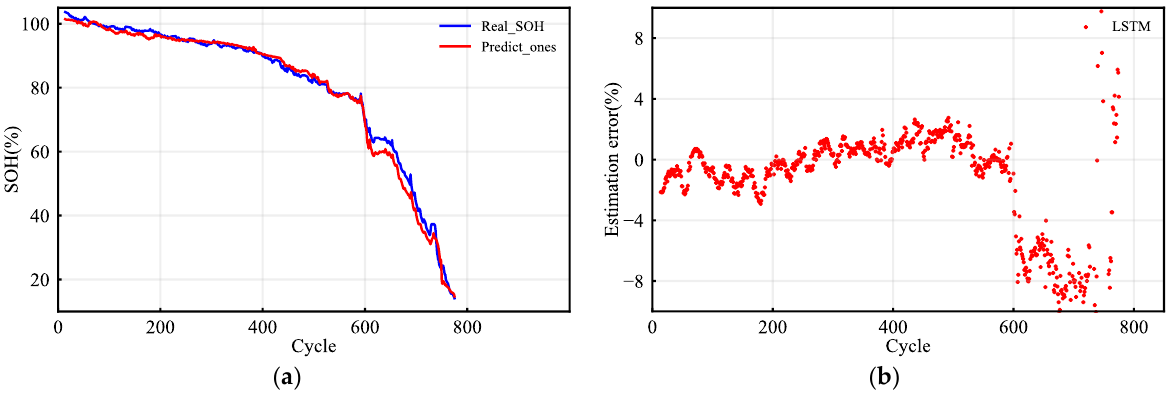
Figure 11. SOH estimation results based on the battery CS2-33; ( a ) SOH estimation for CS2-33; ( b ) SOH estimation error for CS2-33. Table 4. The RMSE and MAE results for the different testing cells above 80% SOH.